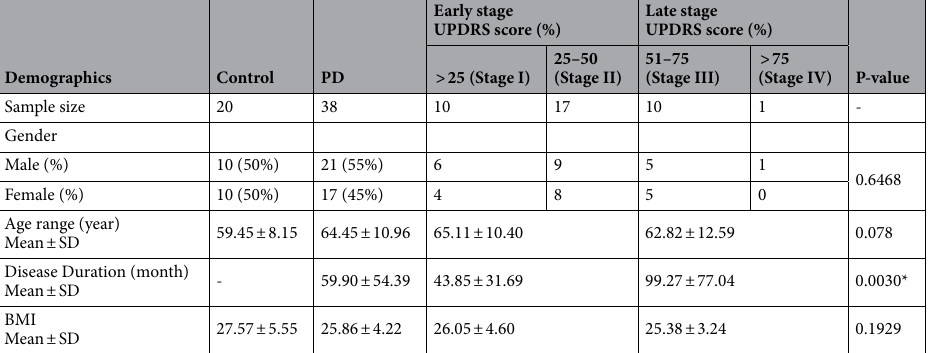
Table 2. Demographic and clinical details of PD patients and controls. p-value was calculated using Unpaired t test. *The difference between the two groups was significant (P >